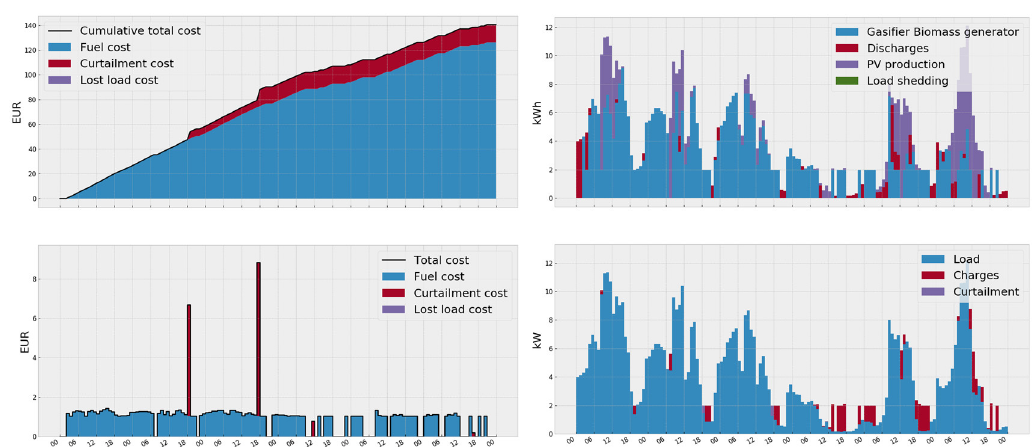
Figure 4. Total costs (left) and generation/load mix – right (The load mix on the graph here does not mean the entire total load of the microgrid, but only an illustration of what components of the electricity consumption (load, battery, or curtailment) the generated power were used to ensure balance) of di ff erent microgrids’ configurations for optimal policies, π ∗ obtained using the Monte-Carlo tree search (MCTS) for the one-week testing